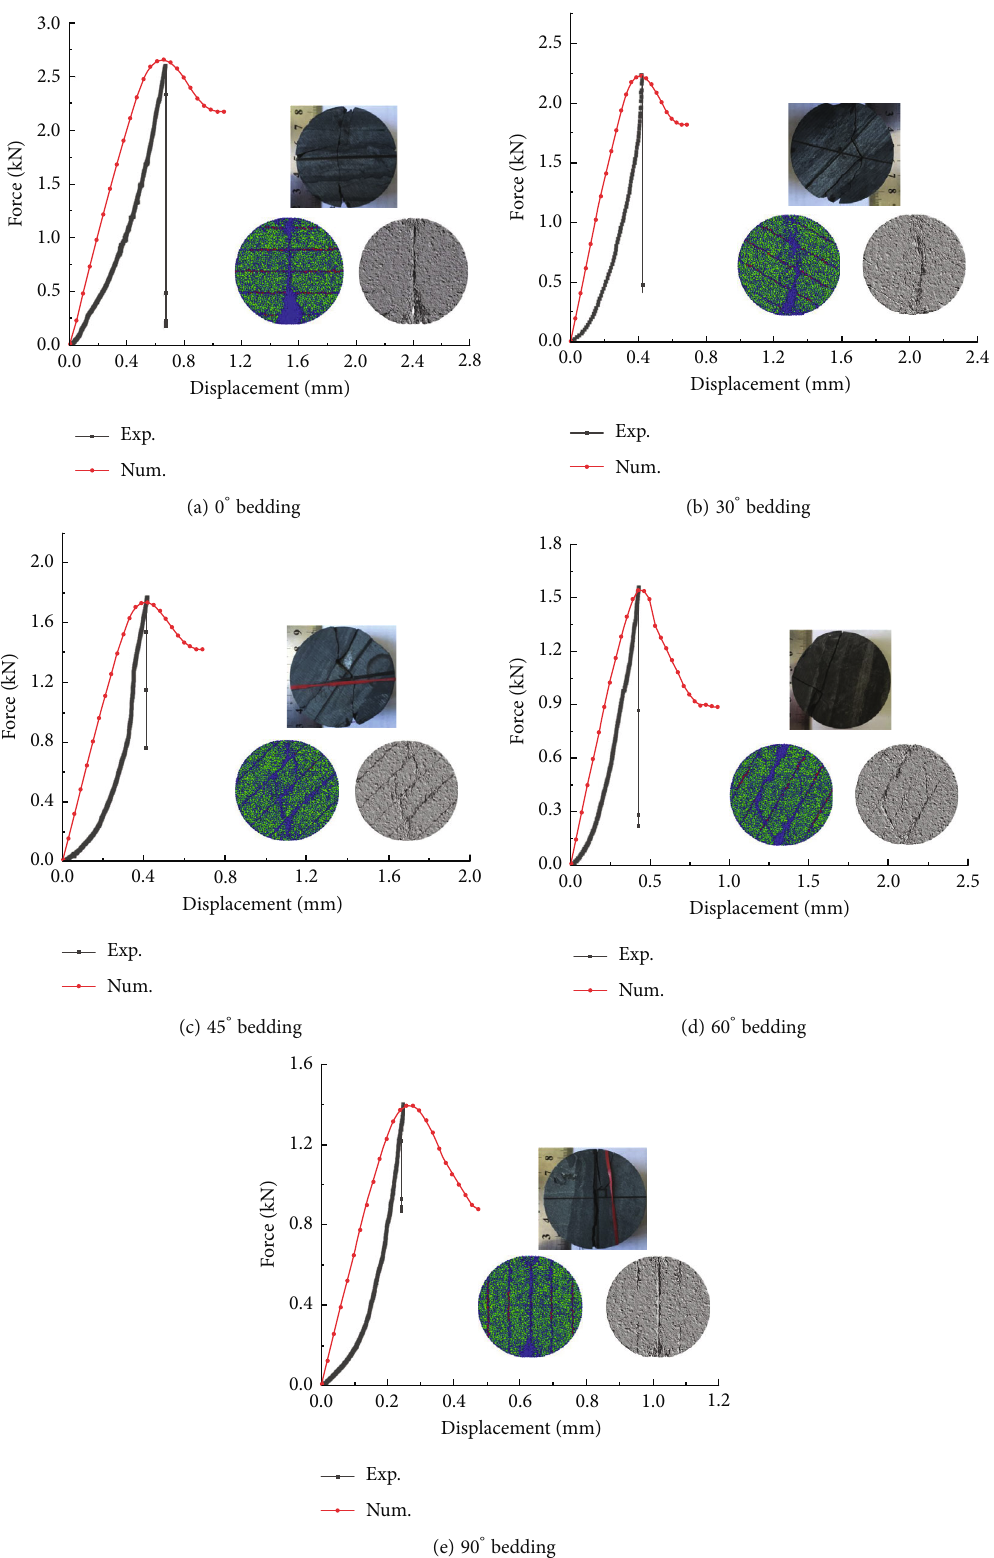
Figure 14: Comparison of load-displacement curves and fracture modes between test and simulation under di ff erent bedding inclination